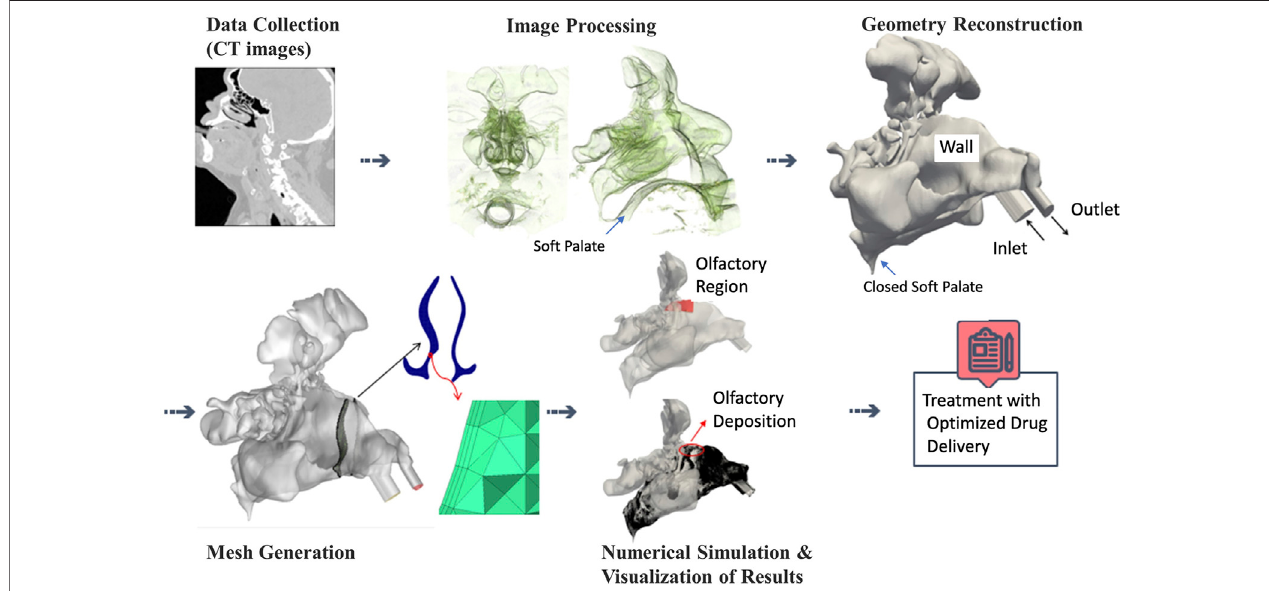
FIGURE 1 | The work fl ow for modeling of patient-speci fi c olfactory drug delivery starting from acquisition of CT images over geometry reconstruction and mesh generation to numerical simulation and visualization of particle-laden air fl ow (Farnoud et al., 2020a). For bi-directional aerosol fl ow, the soft palate needs to be closed, which is illustrated in top